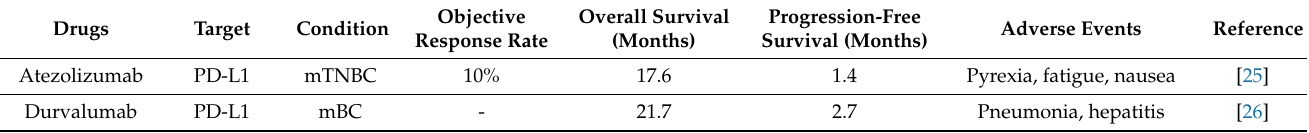
Table 1. Treatment outcome of clinical trials for PD-1/PD-L1